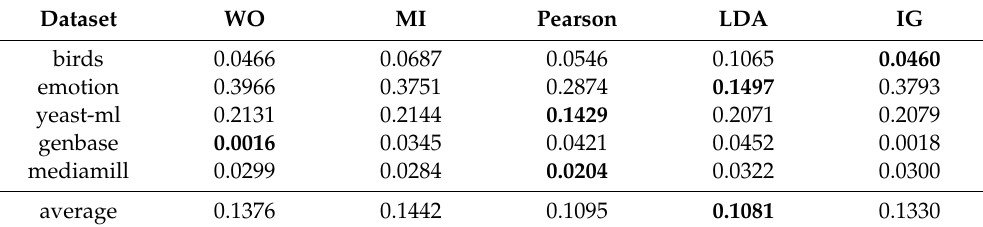
Table 6. Testing HL obtained by ML-Scheme with di ff erent reduction techniques.